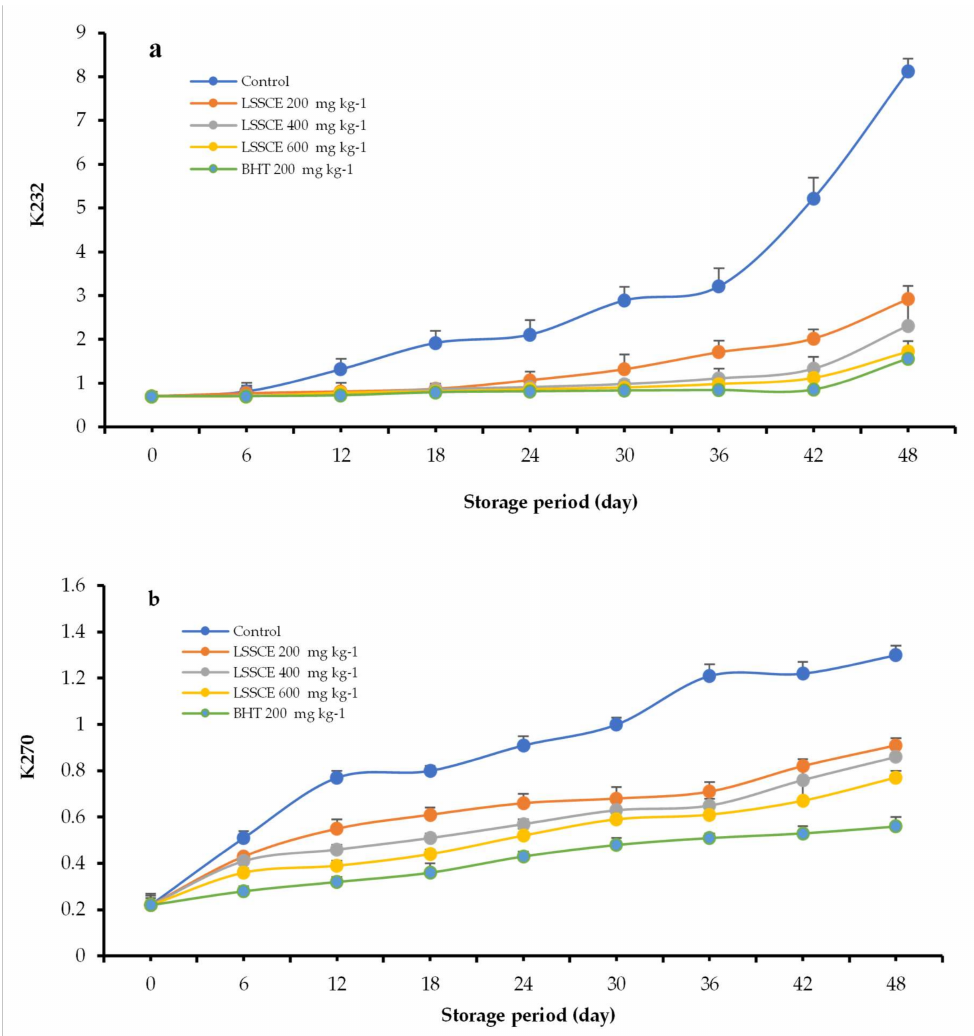
Figure 3. Impact of LSSCE on K 232 ( a ) and K 270 ( b ) in ROO stored at 60 ◦